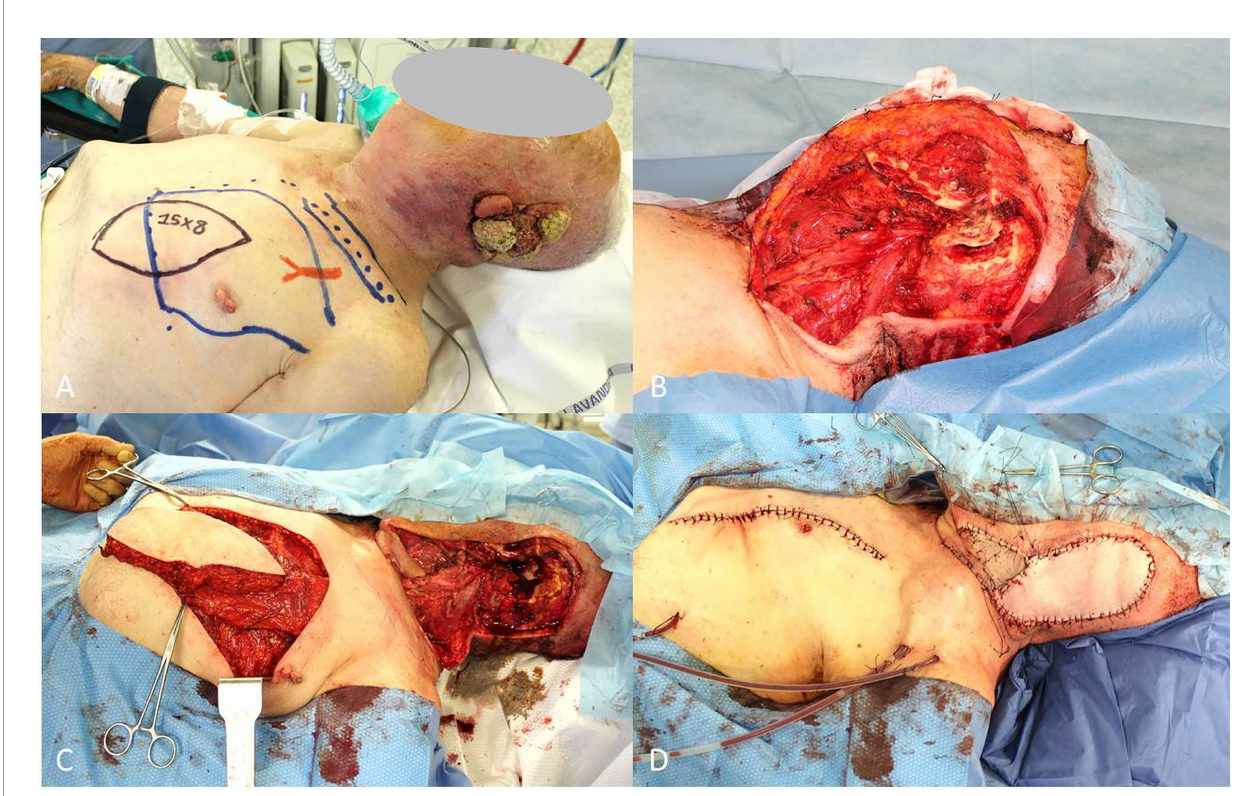
FIGURE 7 | (A) Locally advanced SCC of the ear and planning of pectoralis major muscle fl ap; (B) End of petrosectomy and neck dissection; (C) Pectoralis muscle fl ap harvested; (D) Final result after fl ap